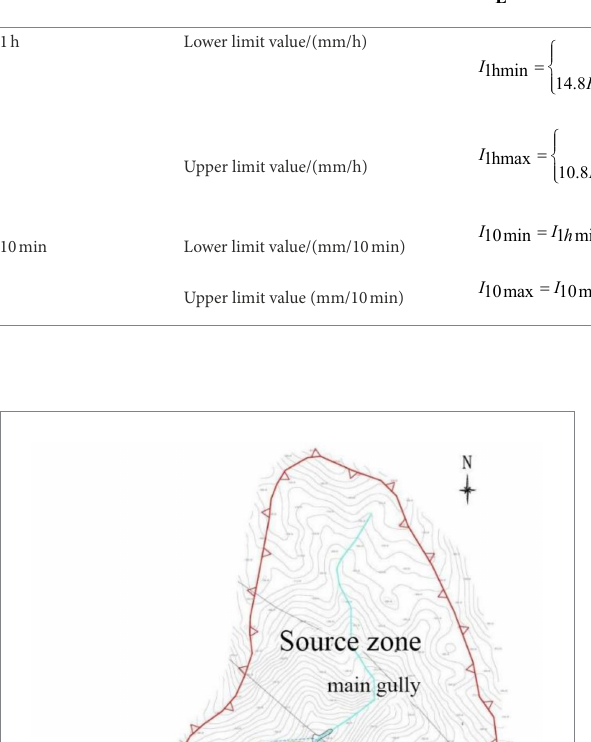
TABLE 3 Calculation formula of critical rainfall for 1 h and 10 min. Rain intensity